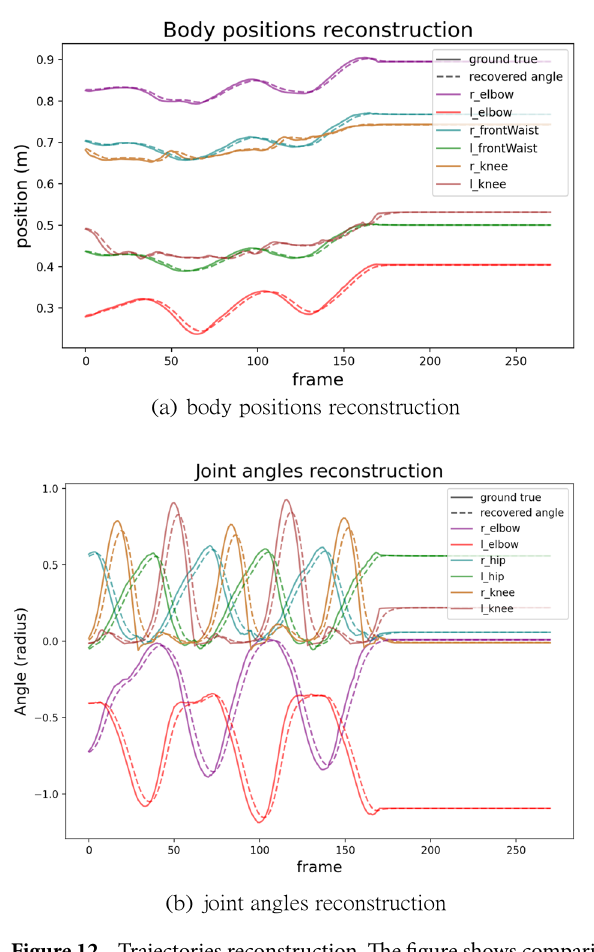
Figure 12. Trajectories reconstruction. The figure shows comparisons between the raw motion capture data shown in the solid lines and the recovered motions in dashed lines along selected dimensions. ( a ) Shows the comparison of body positions along the y-axis. ( b ) Shows the comparison of joint angles along the